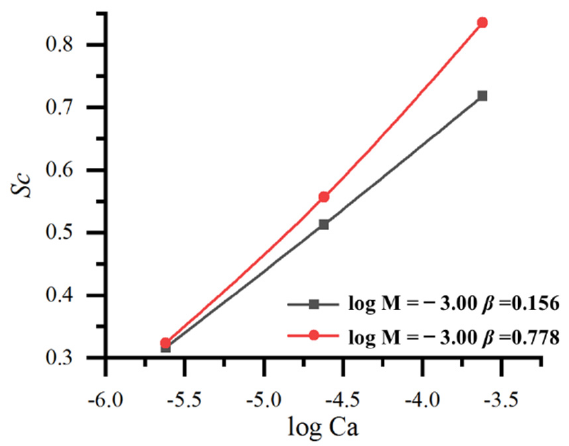
Figure 14. CO 2 saturation ( Sc ) vs. log Ca for same log M.